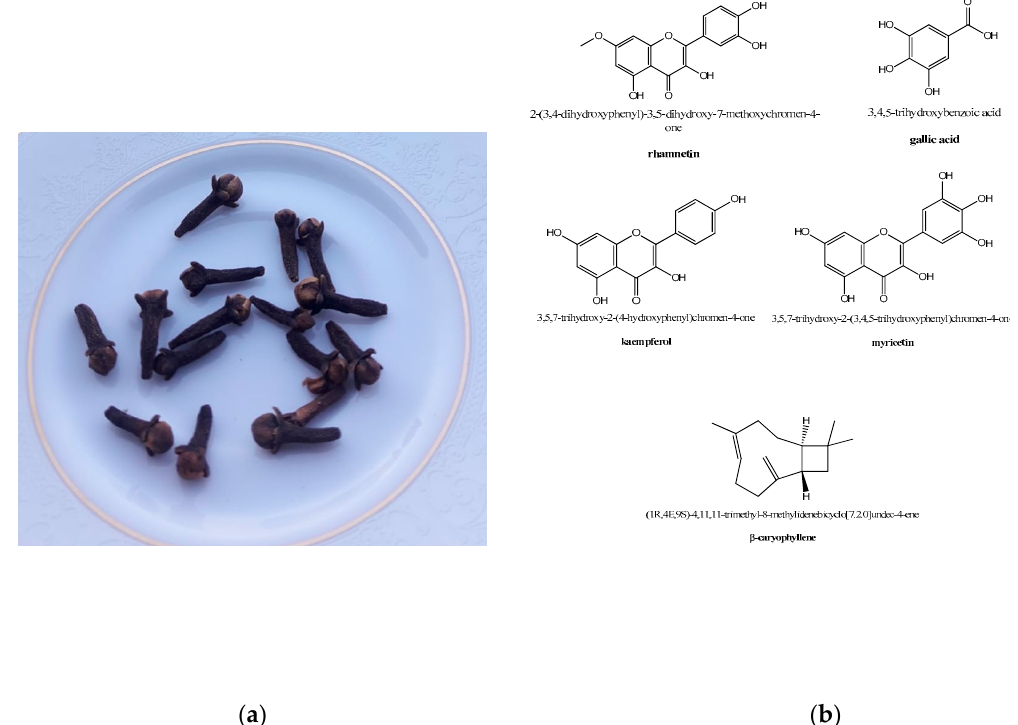
Figure 1. Clove, from culinary use to herbal medicine: ( a ) edible clove buds (photo taken by Giovanni N. Roviello). ( b ) Structure representation of some phytochemicals extracted from Syzygium aromaticum endowed with anti-inflammatory properties.